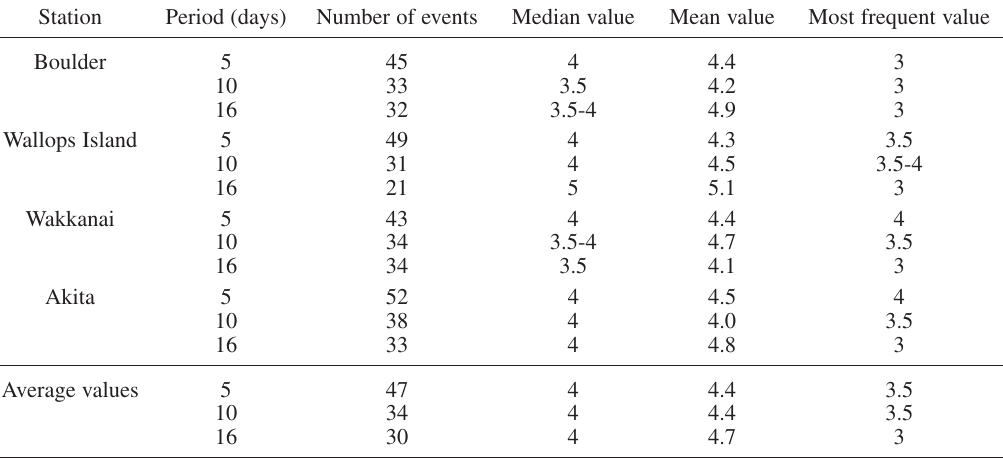
Table III. Statistics of persistence of planetary wave type oscillations in foF 2 for stations from the Northern America and Japan based on the Morlet wavelet transform (absolute values). The average values for medians and the most frequent values are presented with a step of 0.5. Station Period (days) Number of events Boulder